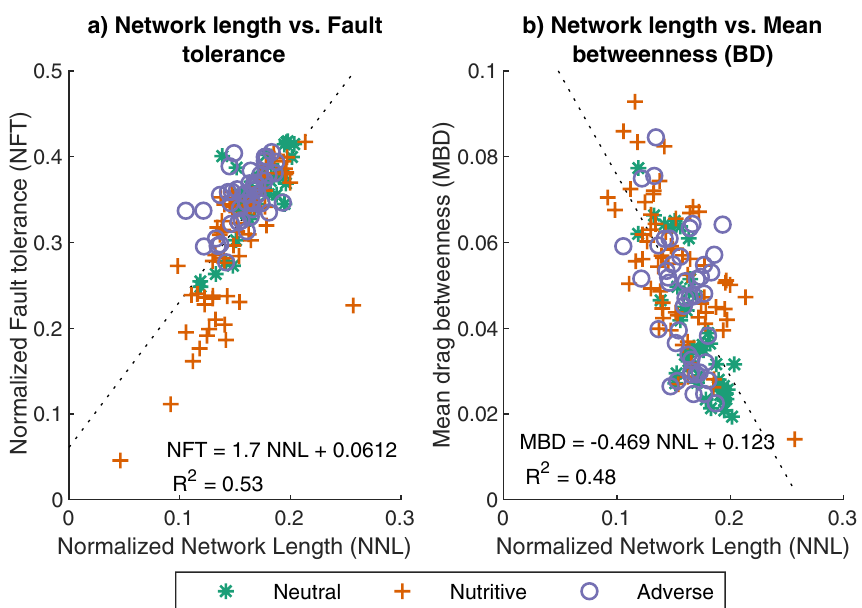
Figure 13. ( a ) Relationship between normalized network length (NNL) and random fault tolerance for 50% connected nodes (FT50). ( b ) Relationship between normalized network length (NNL) and mean drag betweenness